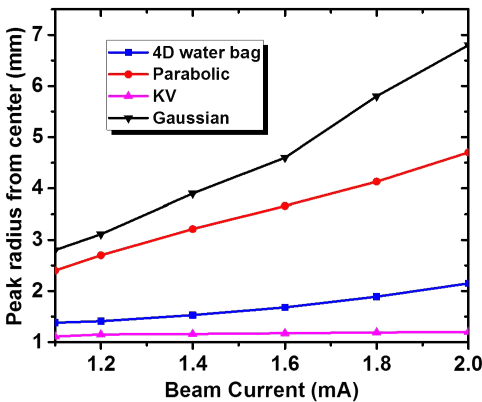
FIG. 5. Variation of the radius of the peak of the density distribution of the HOMB, for Gaussian, parabolic and 4D waterbag and KV initial distributions, as a function of beam